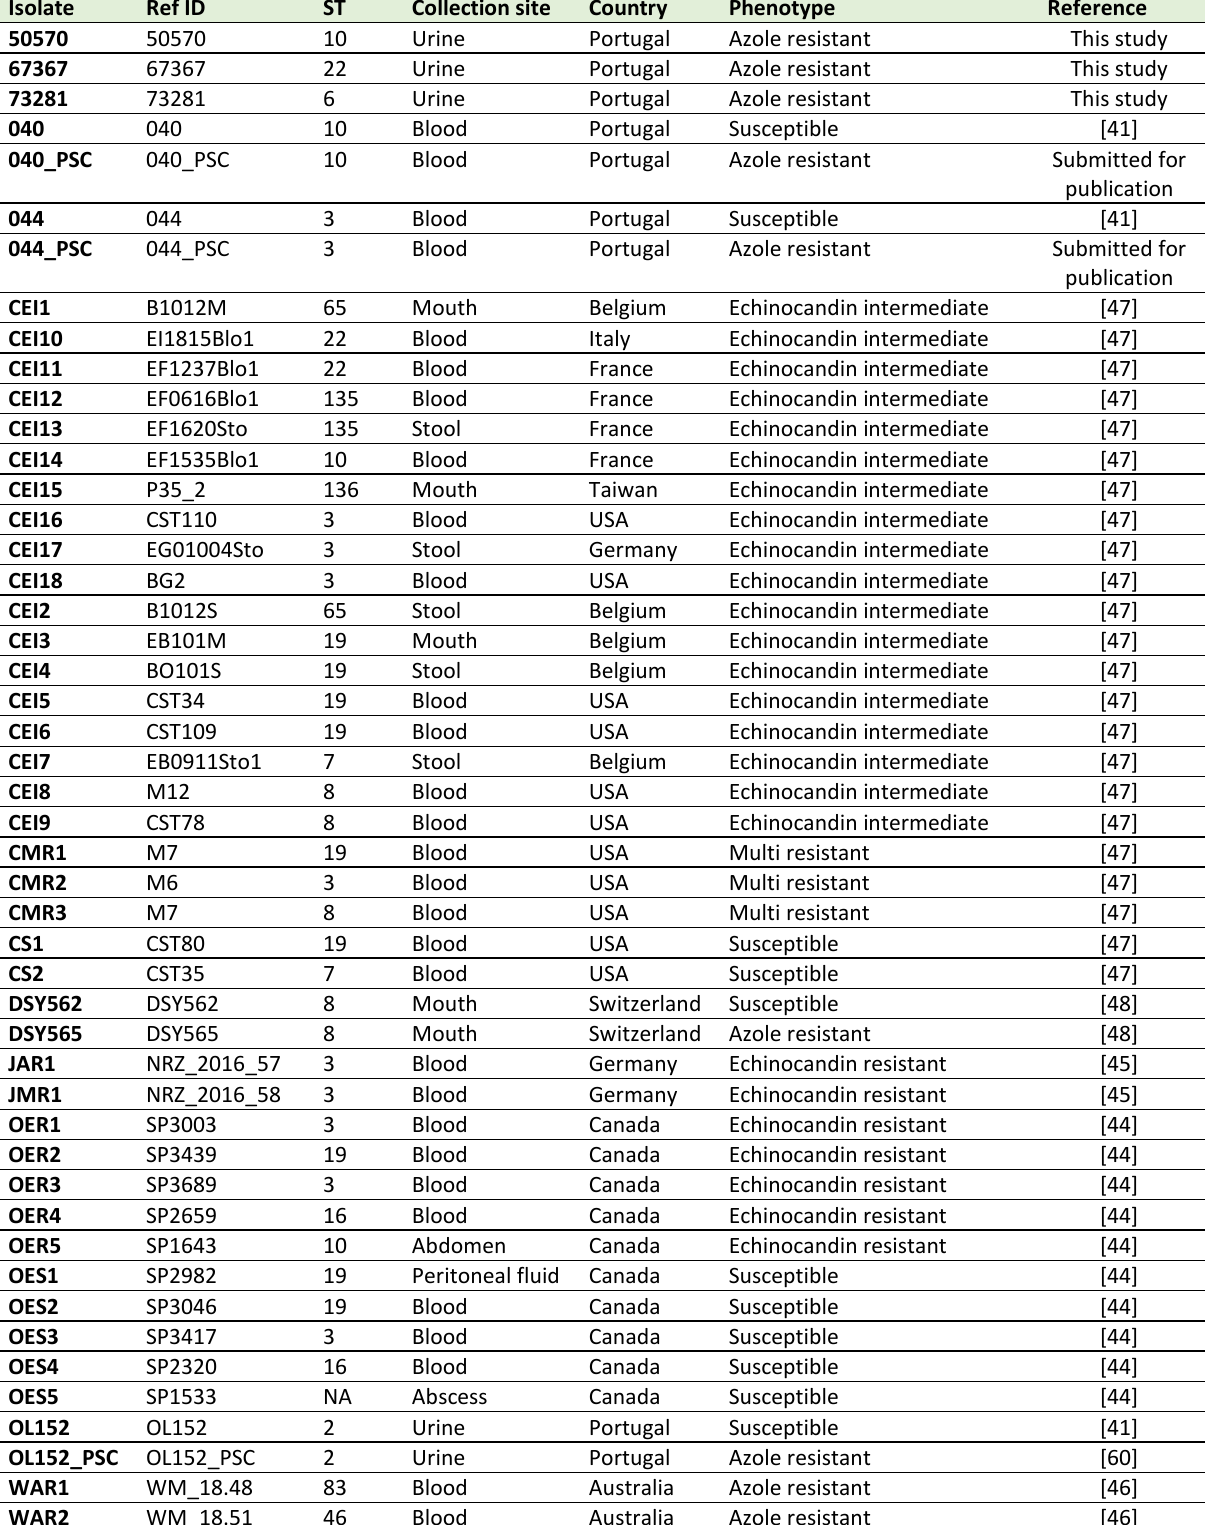
TABLE 1. Data on the 97 C. glabrata isolates analyzed in this study. Isolate Ref